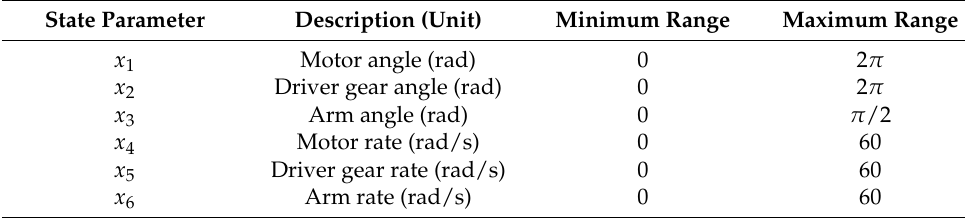
Table 4. Proposed range values of state